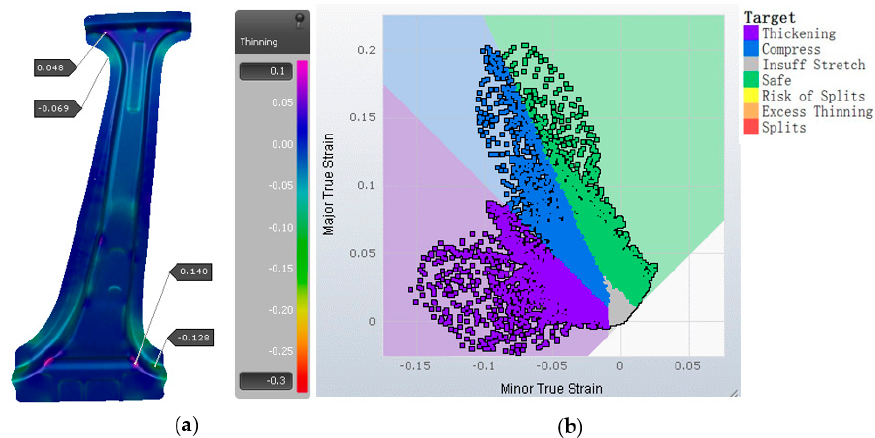
Figure 14. ( a ) Thickness distribution; ( b ) forming limit diagram of the B-pillar.